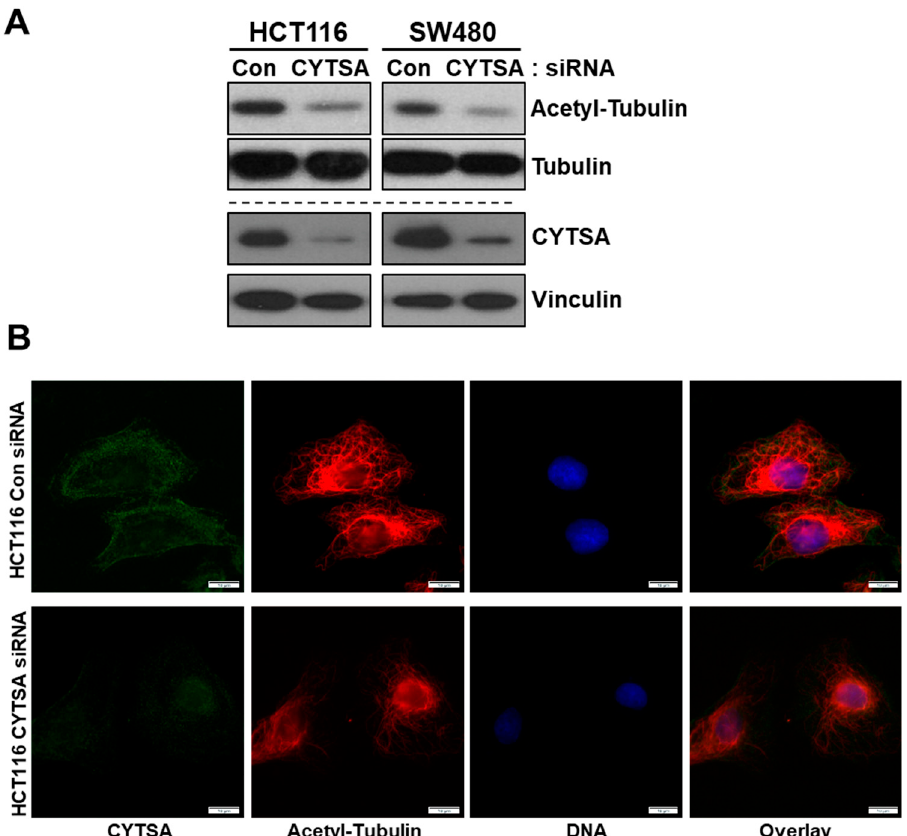
Figure 5. CYTSA depletion reduces the stability of microtubules in CRC cells. ( A ) Lysates of HCT116 and SW480 cells transfected with Con siRNA and CYTSA siRNA were analyzed for levels of acetylated α‐ tubulin and tubulin by Western blotting. The same lysates were also analyzed for levels of CYTSA to validate the knockdown of CYTSA. Vinculin was measured as a loading control. ( B ) HCT116 cells transfected with either Con or CYTSA siRNA were fixed in methanol and stained with antibodies against CYTSA (green) and acetylated α‐ tubulin (red). Nuclei were stained with Hoescht. Scale bar = 10 μ m.